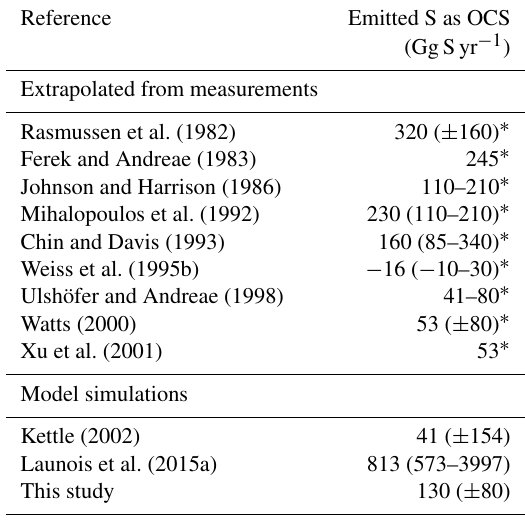
Table 2. Global oceanic emission estimates of OCS: direct ocean emission estimates of OCS from bottom-up approaches. Uncertain- ties are given in parentheses as in the original paper either as range or ± standard